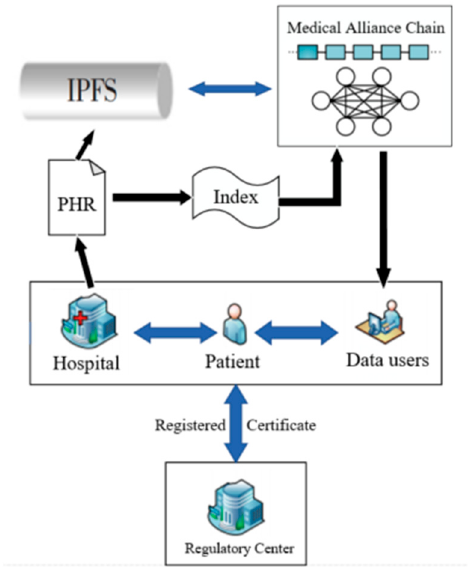
Figure 1. Medical data storage model components.